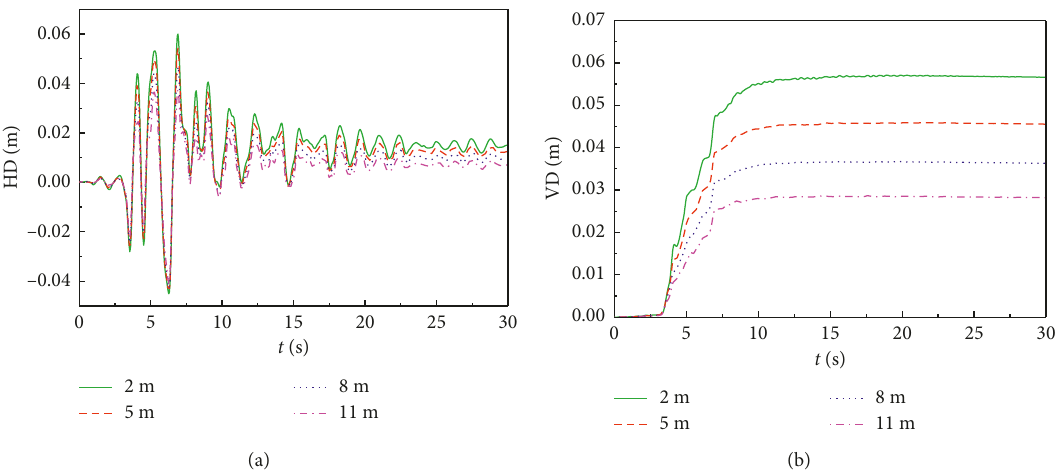
Figure 9: Time history of displacement of subway station structures with different burial depths: (a) horizontal displacement; (b) vertical